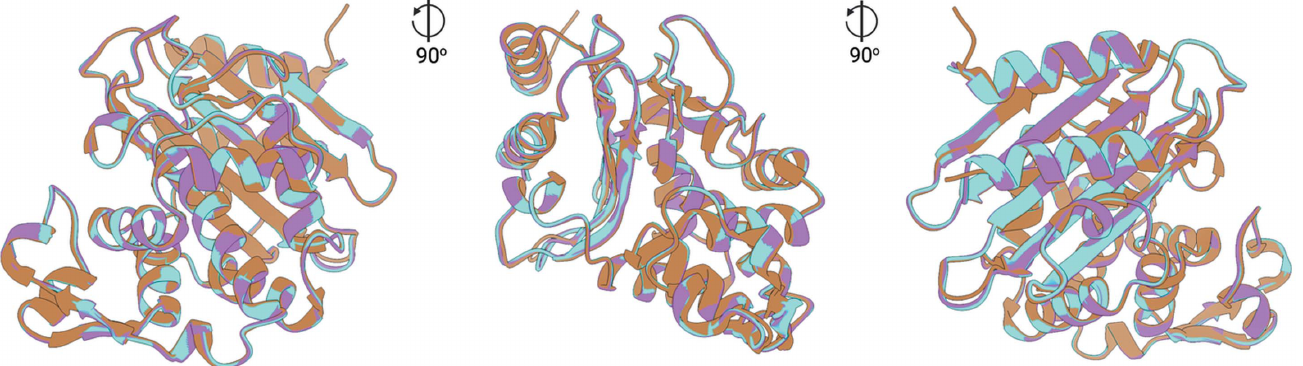
Figure 3 Comparison of the overall structures of CTX-M-14 (cid:2) -lactamase from this study (cyan: 5k dataset; magenta: full dataset) and the cryoMX structure (PDB entry 7q0z, brown). It can be seen that, aside from the differences in symmetry and unit-cell dimensions, the asymmetric units align very